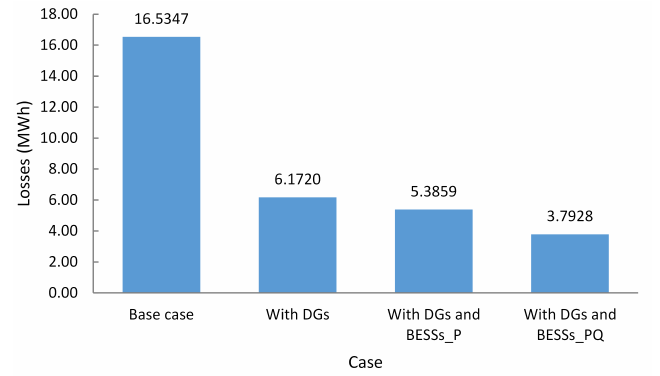
Figure 12. 141-bus system losses.